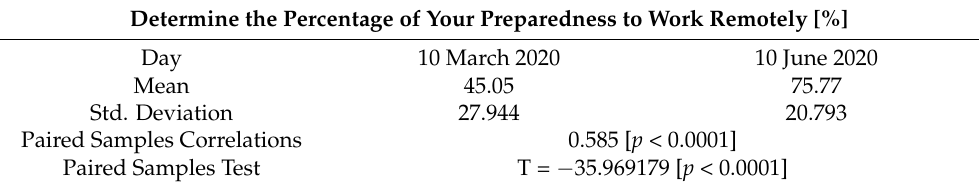
Table 1. Statistics for determining the percentage of respondents’ preparedness to work remotely.